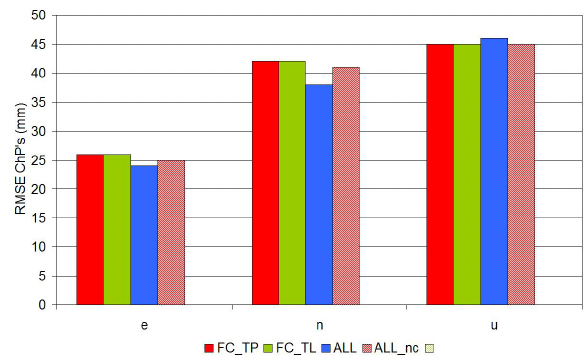
Figure 3: RMSE of